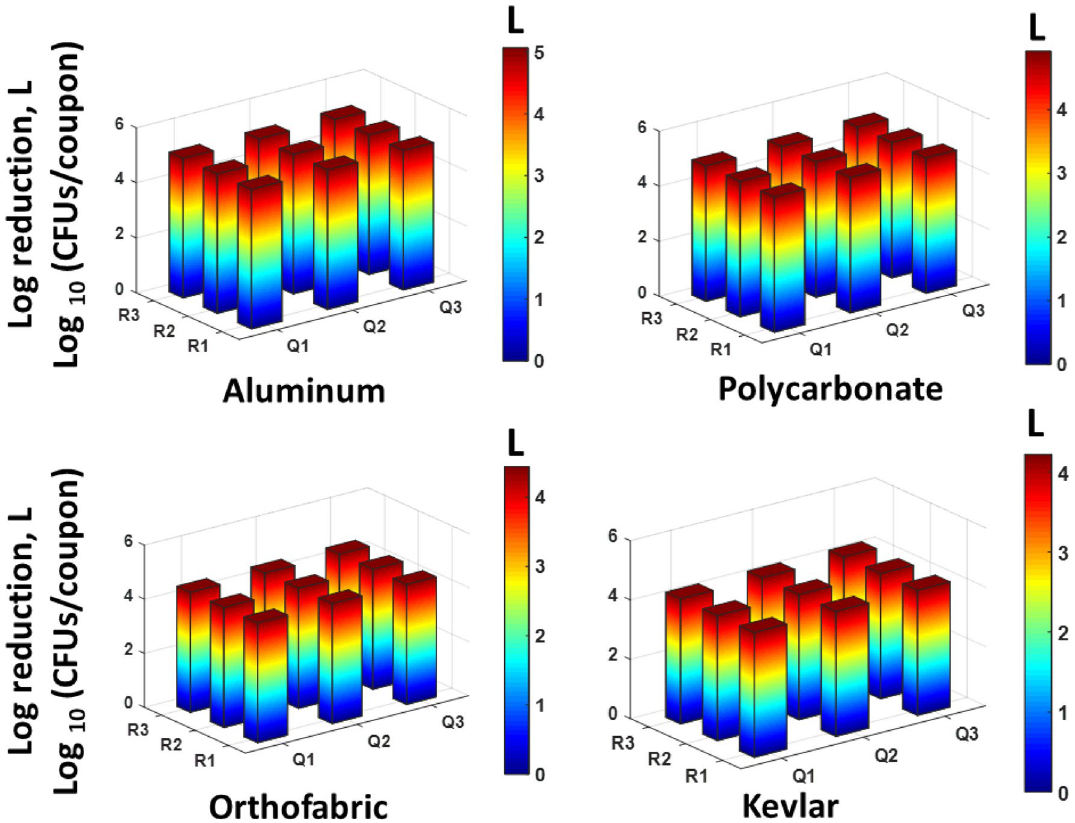
Figure 12. Data showing uniform spatial distribution of reduction in logs of B. subtilis CFUs/coupon of 9 exposed coupons placed at the central plane of the APS, for each material type. The x and y axis represent the location in the measurement grid illustrated in Fig. 4. Both the z axis and the color bar indicate log reductions achieved in the coupons—double representation was selected for clarity. 4 to 5 log reduction was achieved at all points using 6 CPPRs and exposures of 30 min (25 min CPPR on + 5 min CPPR